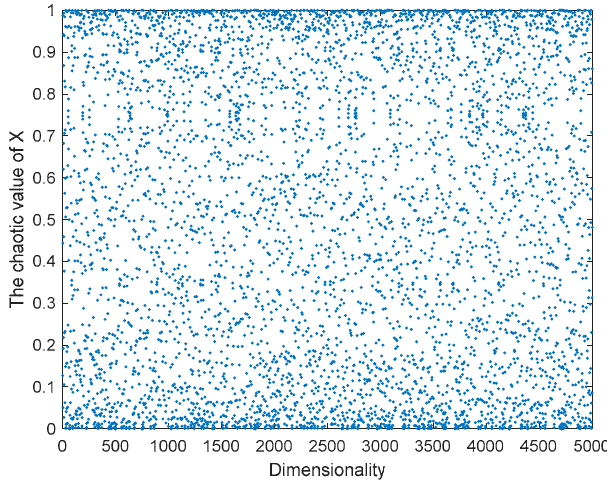
Figure 2. Logistic chaos value distribution.